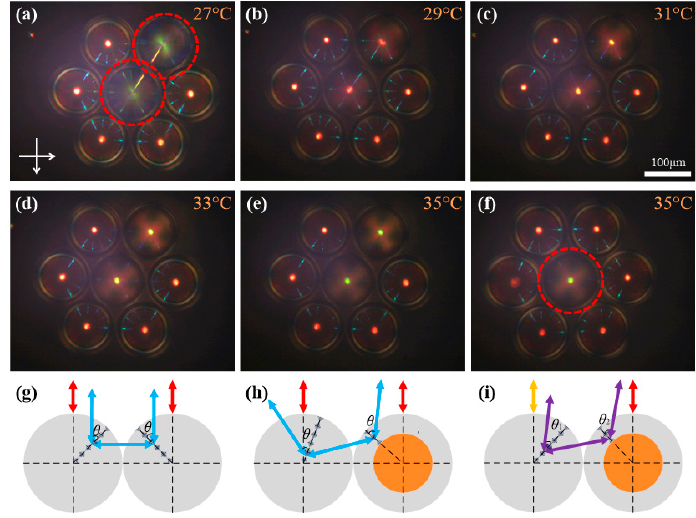
Figure 4. ( a – f ) POM images of the cross-communication between microdroplets and microshells with different pitches and inverse helicity handedness in close-packed hexagonal arrangements. The samples circled in red are T -droplets. ( g – i ) Schematic mechanism of the reflection between ( g ) microdroplets, ( h ) microdroplets and microshells with same pitch, and ( i ) microdroplets and microshells with different pitches.